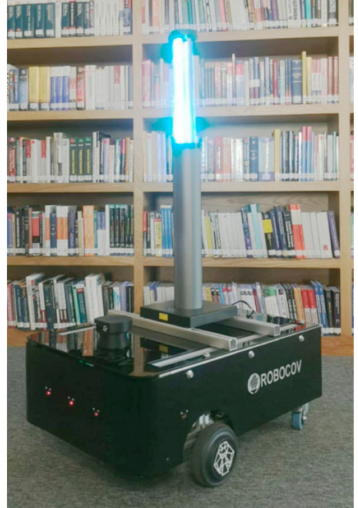
Figure 27. UV module operating in the